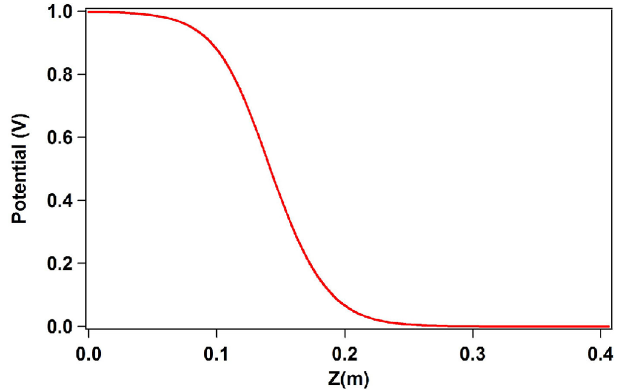
FIG. 15. (Color) Plot of the on-axis electrostatic potential for the mirror as a function of longitudinal position starting from the center of the mirror tube. A voltage of (cid:6) 1 V was applied to the mirror tube.